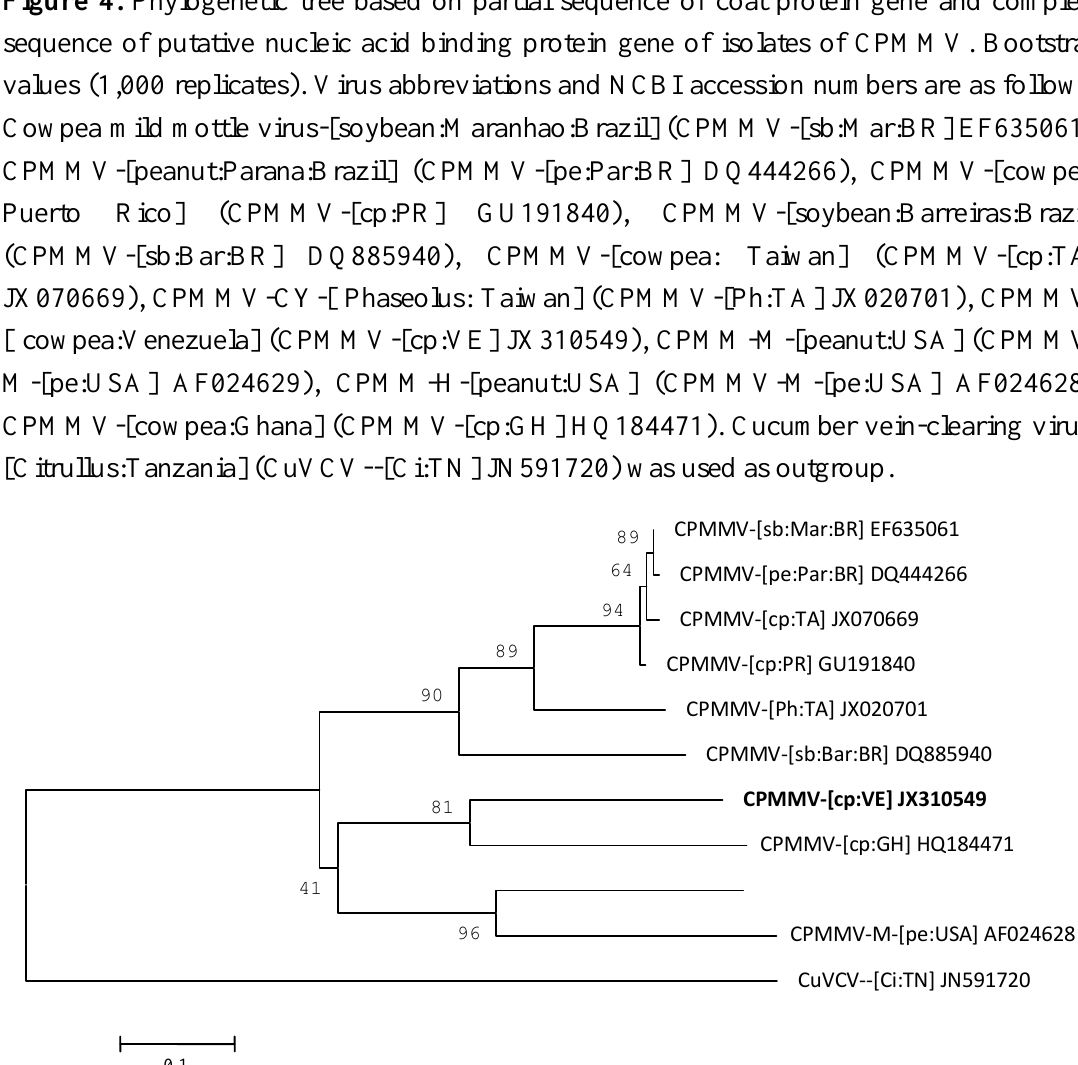
Figure 4. Phylogenetic tree based on partial sequence of coat protein gene and complete sequence of putative nucleic acid binding protein gene of isolates of CPMMV.